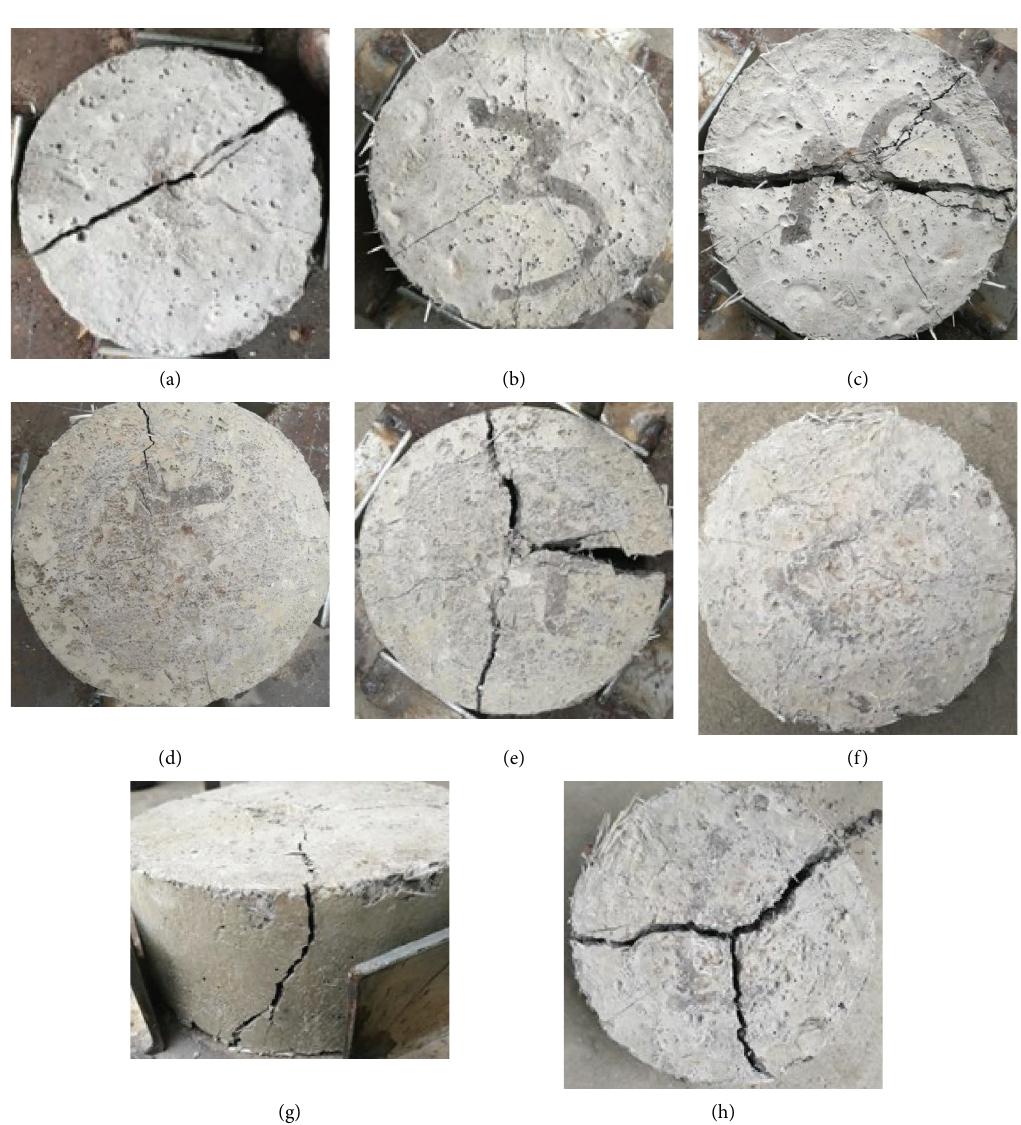
Figure 9: ARGFRC impact resistance crack: (a) IR-FC0; (b) IR-FC0.5 (initial crack); (c) IR-FC0.5 (damage crack); (d) IR-FC1.0 (initial crack); (e) IR-FC1.0 (damage crack); (f) IR-FC1.5 (initial crack); (g) IR-FC1.5 (side view crack); and (h) IR-FC1.5 (damage crack).